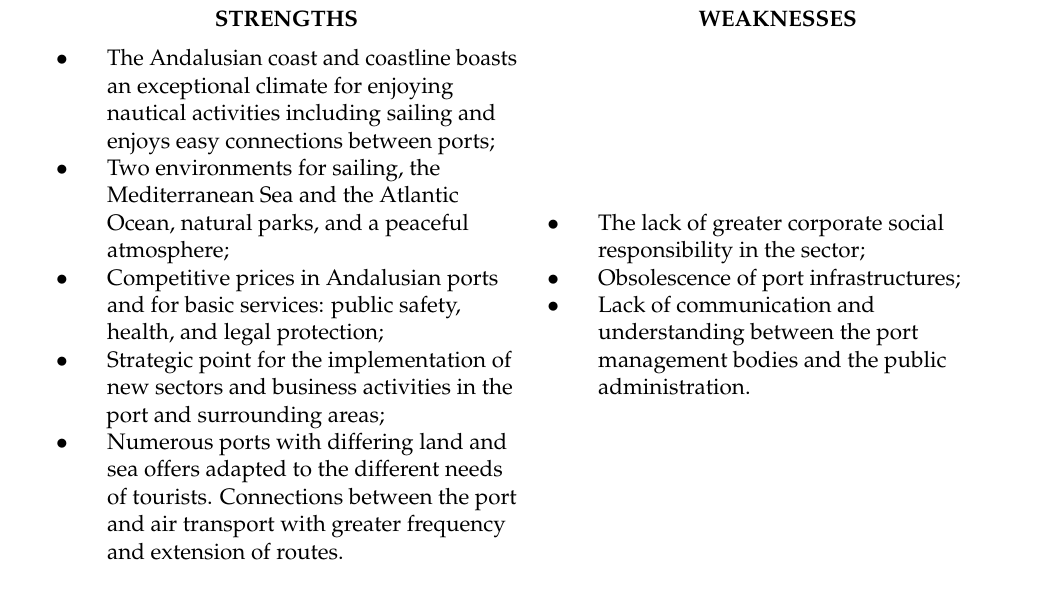
Table 4. SWOT Table 4. SWOT Matrix.